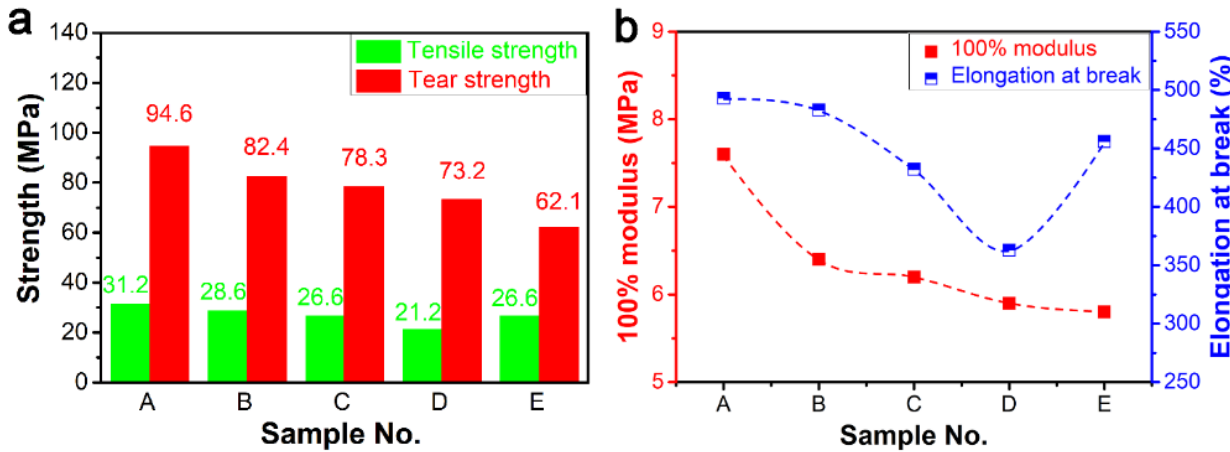
Figure 3. Effect of DCP dosage on the mechanical properties of the ER composites: ( a ) tensile strength and tear strength; ( b ) 100% modulus and elongation.